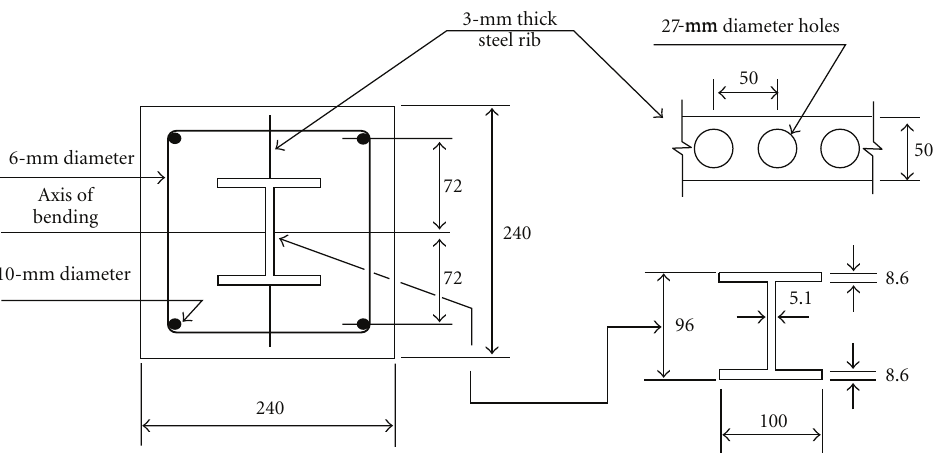
Figure 15: Cross-section details of Specimens RHB-1, RHB-3, and RHB-4A used for comparison of load-deflection behavior (dimensions are in